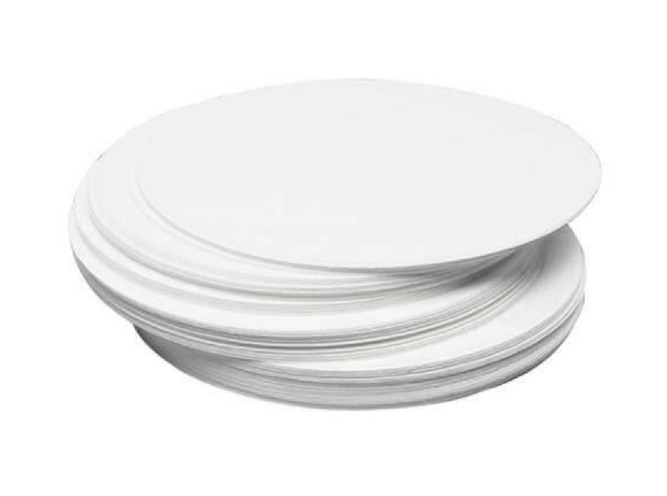
The Filter paper.